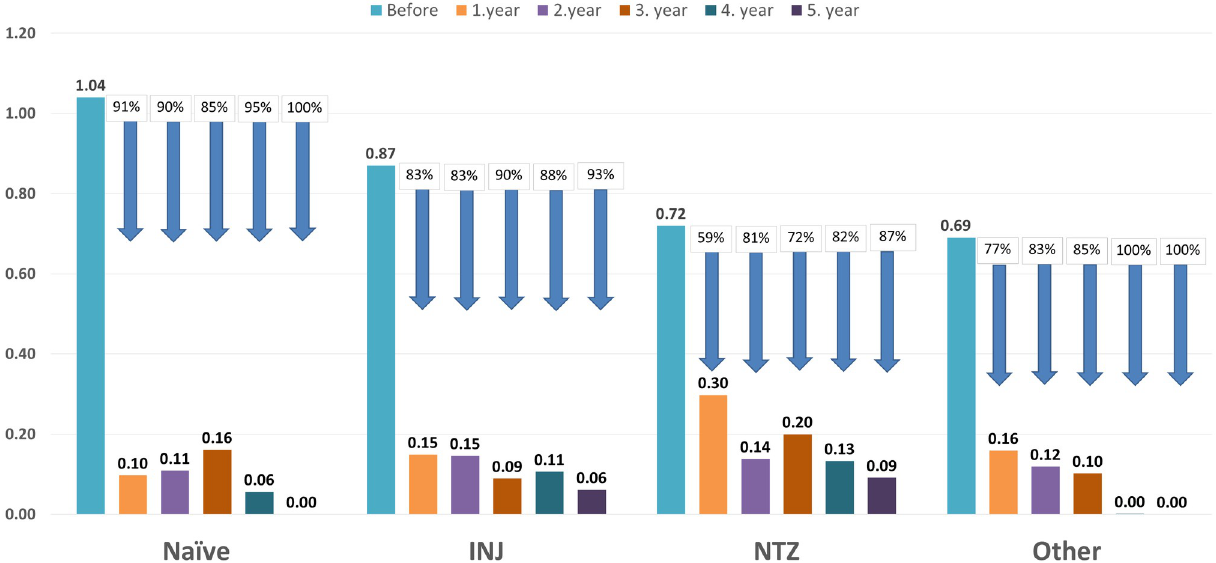
Fig 1. Annualised relapse rate of the study subgroups. Annualised relapse rate at baseline and 1, 2, 3, 4, and 5 years after initiation of treatment with fingolimod stratified by previous treatment.